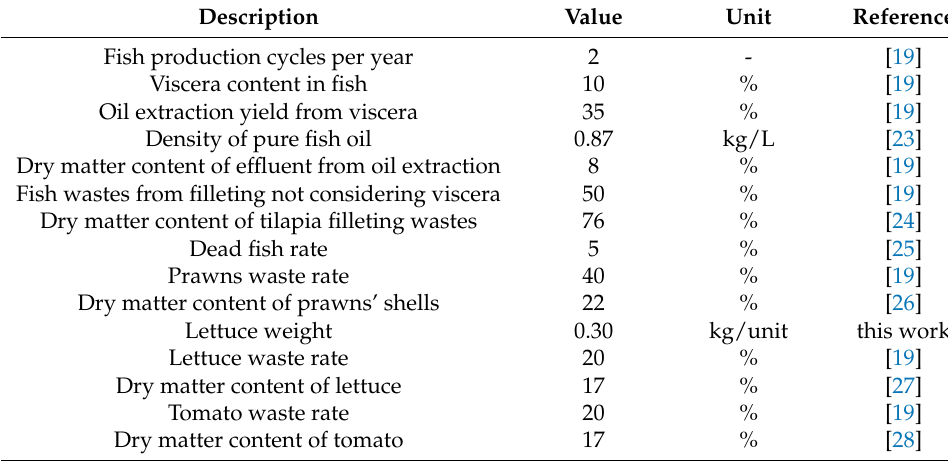
Table 2. The feedstock availability for the biogas production.